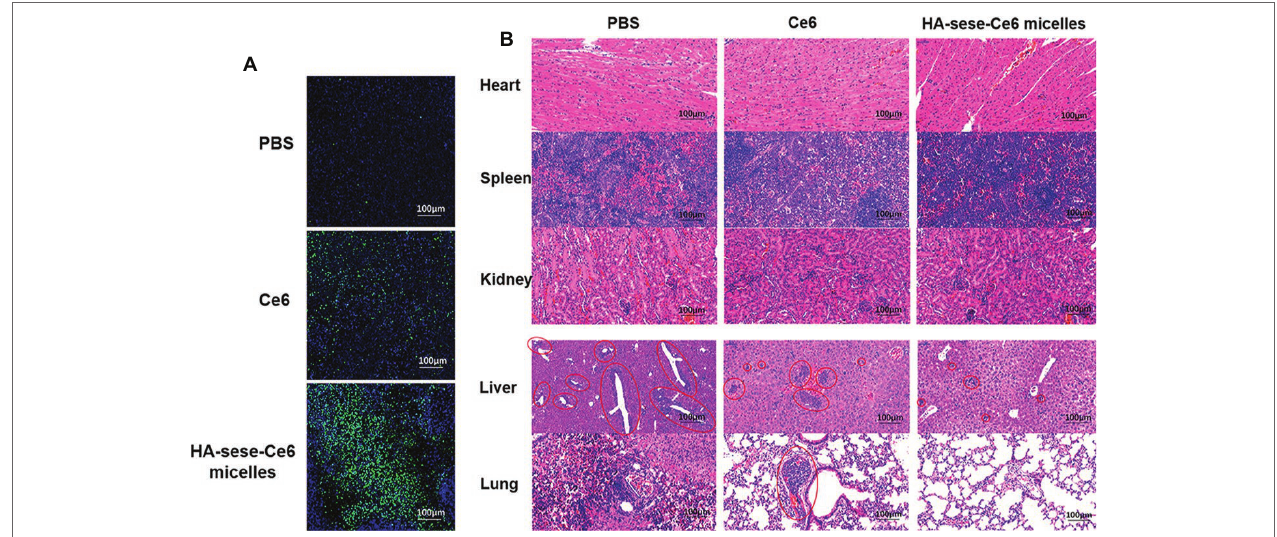
FIGURE 6 | (A) TUNEL staining of excised tumor tissues after free Ce6 HA-sese-Ce6 micelles treatments, PBS treatment as control. Apoptotic cells (green, FITC); Normal cancer cells (blue, DAPI). (B) H&E staining of heart, spleen, kidney, liver, and lung tissues dissected from mice after different treatments on day 26. Red circles represent tumor